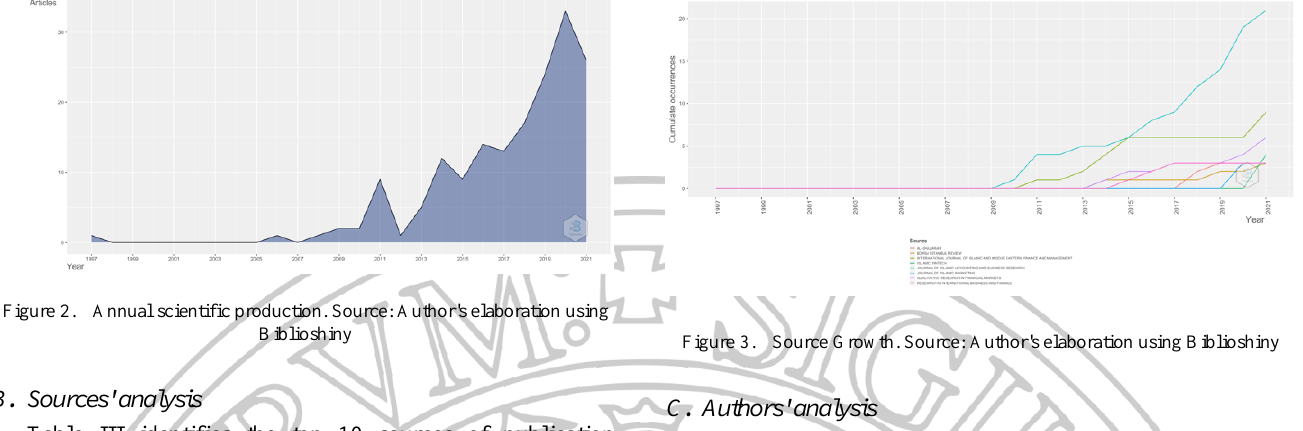
Figure 2. Annual scientific production. Source: Author's elaboration using Biblioshiny Figure 3. Source Growth. Source: Author's elaboration using